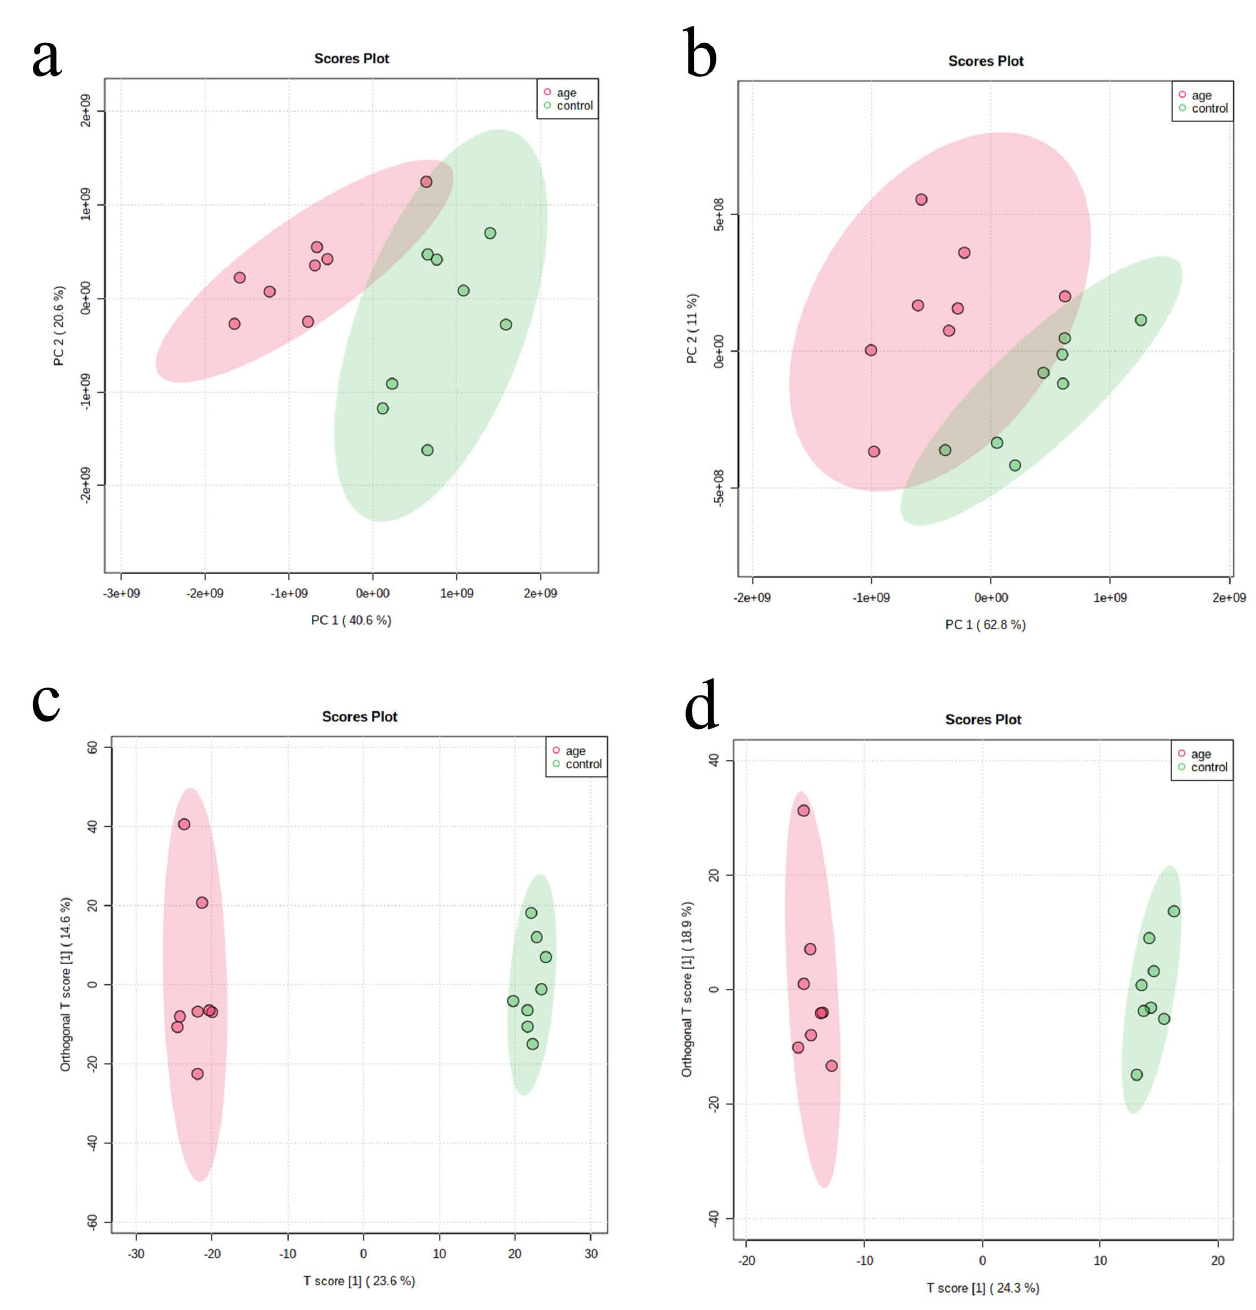
Figure 2. Supervised clustering of serum metabolites using the PCA and OPLS-DA models. ( a , b ) Score plot of the PCA model for samples collected from the two isolates of sample data; ( c , d ) The two groups were well separated in the OPLS-DA score plot. (( a , c ): under the negative modes; ( b , d ): under the positive